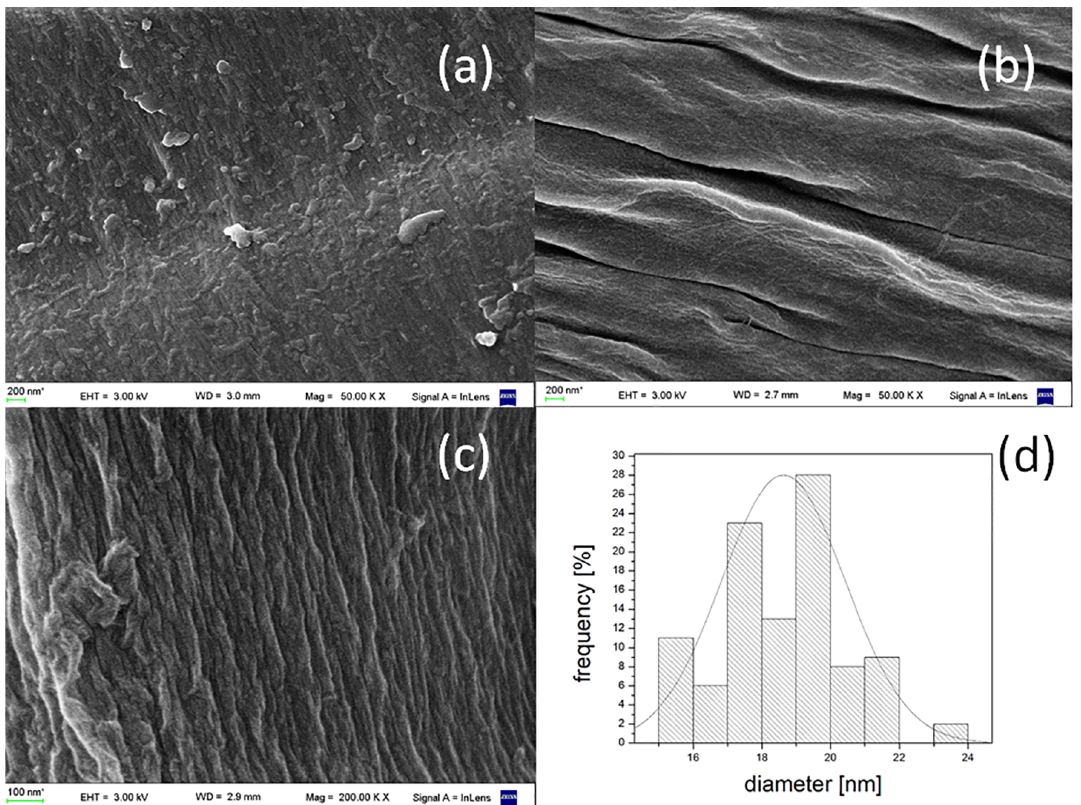
Figure 2. FESEM micrographs of: Cereus Forbesii bark (a), cellulose obtained by alkaline treatment (b), cellulose nanofibers obtained by the acid hydrolysis of cellulose (c), and diameters distribution of cellulose nanofibers